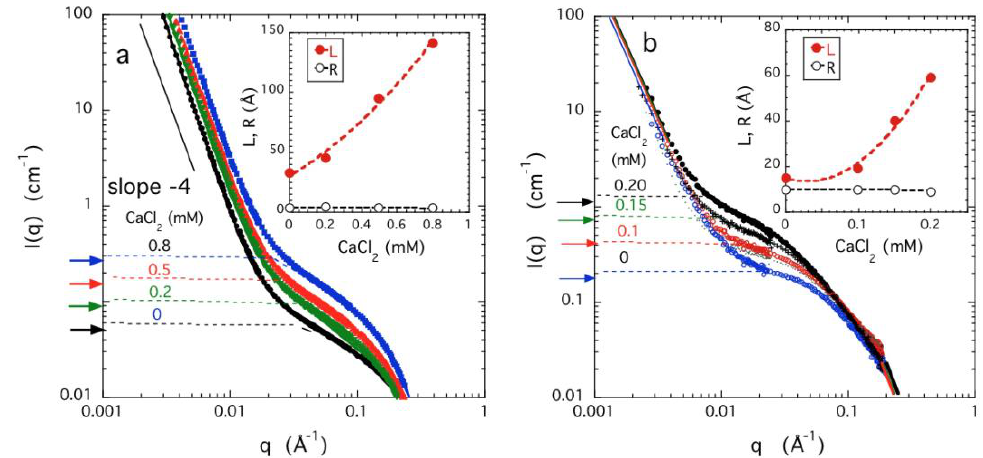
Figure 5. SANS profiles of PAA gels ( a ) and DNA gels ( b ) at c = 0.03 g/cm 3 swollen in 40 mM NaCl solutions with different concentrations of CaCl 2 . Continuous lines are fits to Equation (8), dashed lines are the corresponding dynamic components [ I os ( q )]. Horizontal arrows at left axis are the values of I os (0) calculated from Equation (9) using the osmotic data of Figure 2a,b. Insets: dependence of the correlation length L and the cross-sectional radius R on the CaCl 2 concentration in 40 mM NaCl concentration.